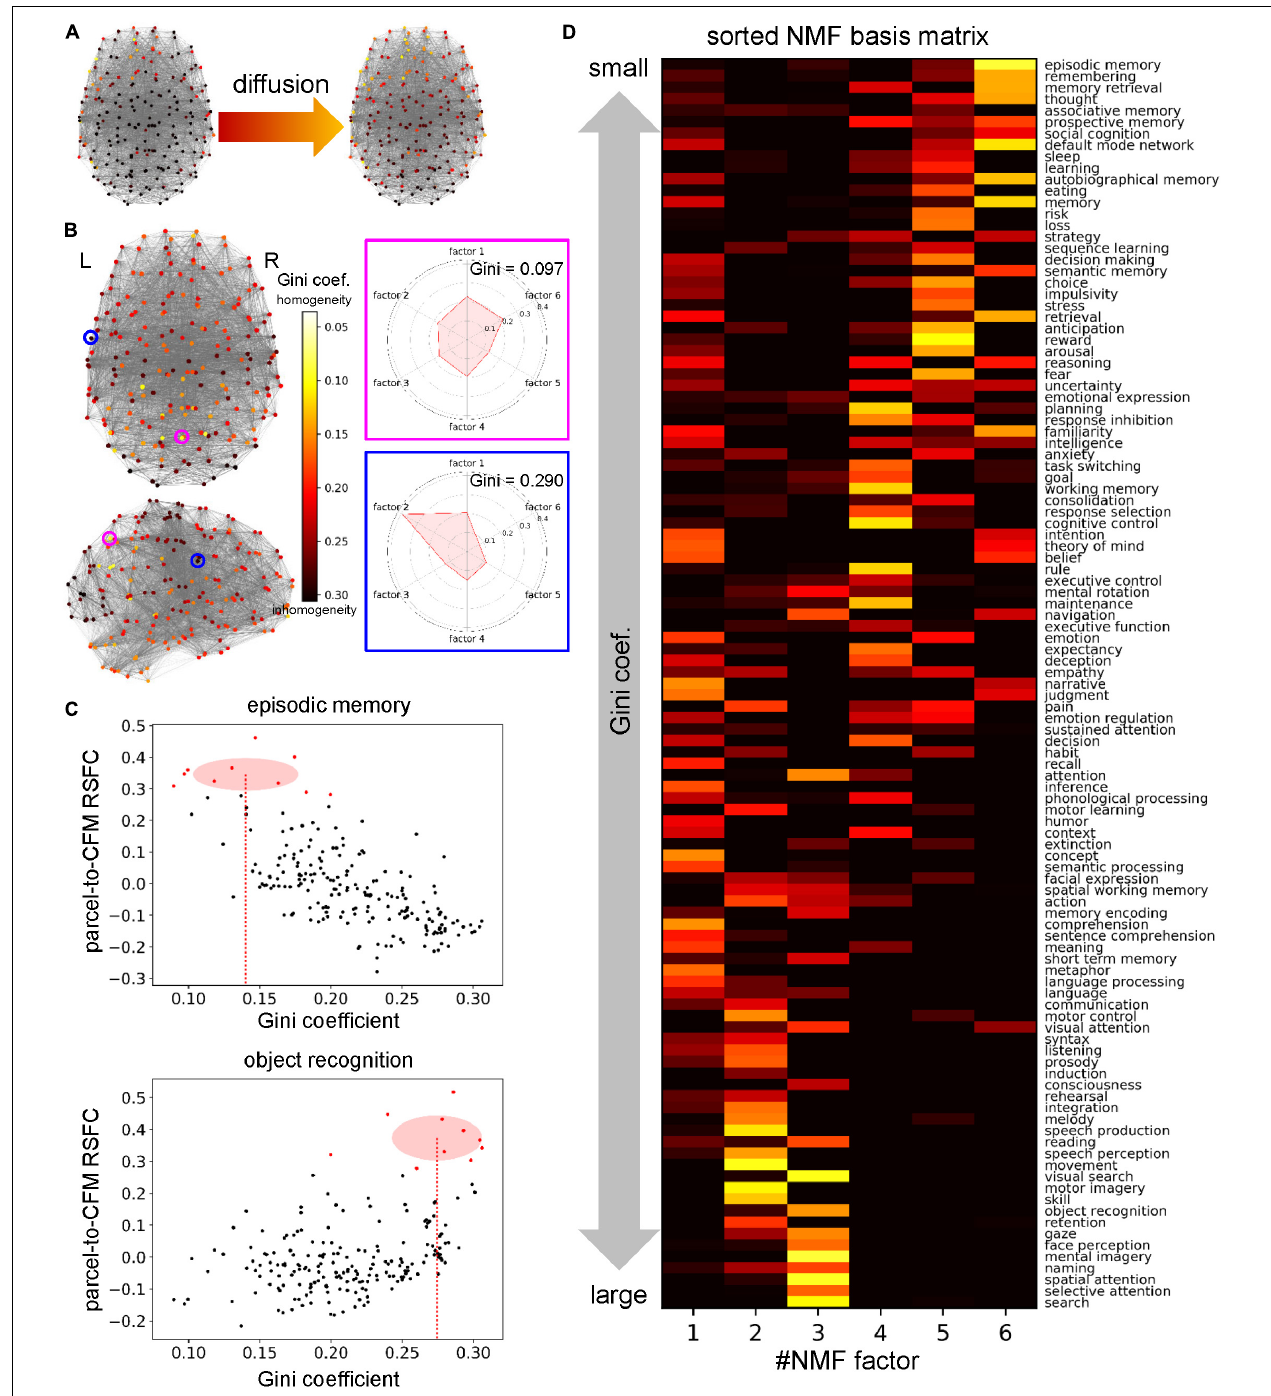
FIGURE 6 | Cognitive factor-dependent diversity of informational interactions. (A) Heat source (left) and temperature (right) distributions on the parcels for the cognitive factor 1. The heat source values were defined as the non-negative matrix factorization (NMF) coefficient values of the corresponding column. Temperatures were calculated at steady states of the diffusion process governed by the graph Laplacian. (B) The Gini coefficient distribution. For each parcel, the Gini coefficient represents inhomogeneity of temperatures across the factors. The Gini coefficients and polar graph of temperature for the parcel circled with magenta and blue are shown on the right. (C) Example plots between the Gini coefficient values and parcel-to-cognitive function map (CFM) resting-state functional connectivities (RSFCs). Upper and lower plots correspond to the CFMs of ‘episodic memory’ and ‘object recognition,’ respectively. Each dot expresses each parcel. The parcels that have the 10 largest RSFCs are red-colored. The means and standard deviations of the Gini coefficients for these red-colored parcels are shown as the centers and radiuses of the red circles, respectively. The means are also indicated by the red dotted line. (D) The transposed NMF basis matrix, sorted by the Gini coefficients. The cognitive function corresponding to each CFM is shown on the